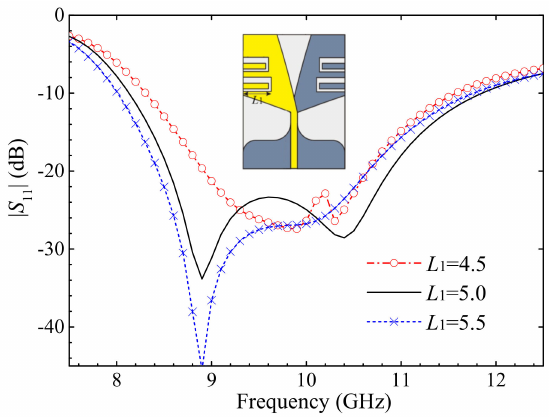
Figure 5. | S 11 | of the designed antenna with different L 1 values (unit: mm).